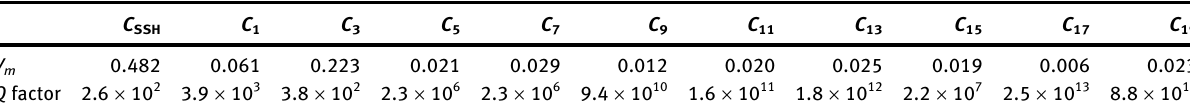
Table  : Mode volumes and Q factors of C  – C  and C SSH . C